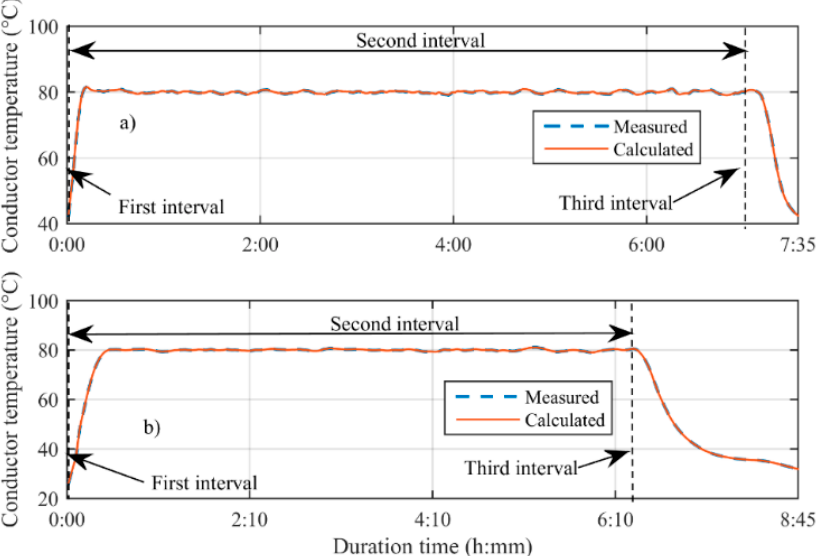
Figure 9. Measured and calculated conductor temperature at the conductor temperature 80 °C for the conductor: ( a ) AlFe 240/40 and ( b ) AlFe 490/65.